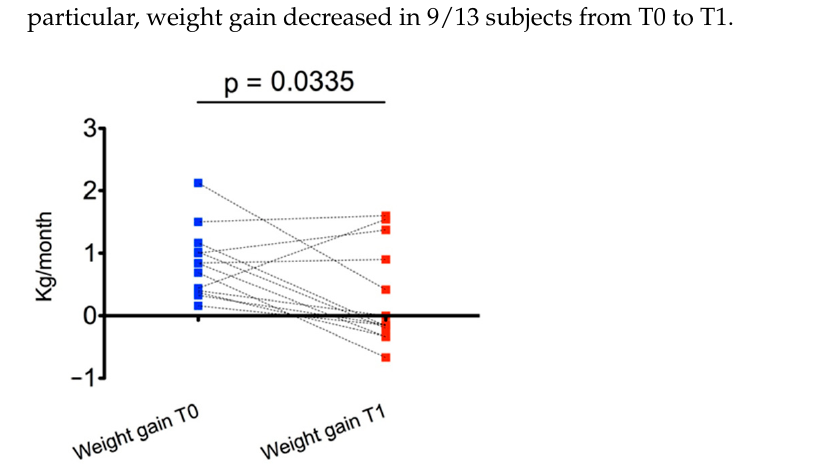
Figure 2. Changes in weight gain (kg/month) during the six months before and the six months after multidisciplinary management.